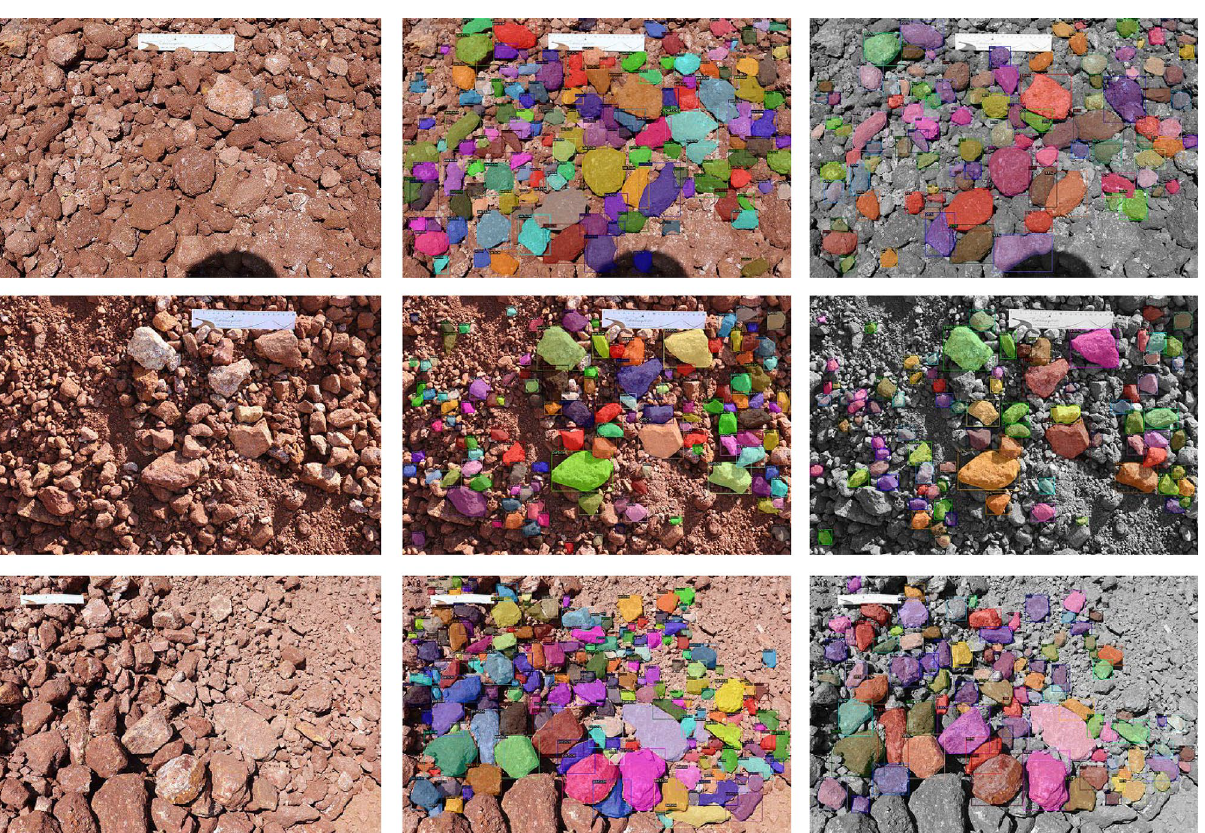
Figure 6. Original, ground truth and predicted results of image ids: IMG_9012, IMG_9078 and IMG_9301 in first, second and last rows